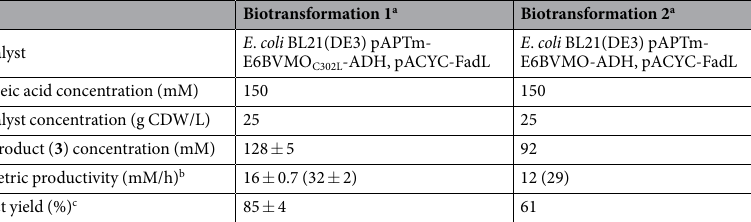
Table 1. Biocatalytic performance of the E6BVMO C302L -based biocatalyst in a bioreactor. a Biotransformation 1 and 2 indicates the experiment shown in Figs 6 and S7, respectively. b Volumetric productivity was calculated based on the ester product concentration, which was determined by GC/MS, and the reaction time, which was measured when > 90% of the starting material was converted to the products. The values in parenthesis indicate initial biotransformation rates, which were measured at t < 2 h. c Product yield was calculated based on the initial substrate concentration and the final ester product concentration, which were determined by